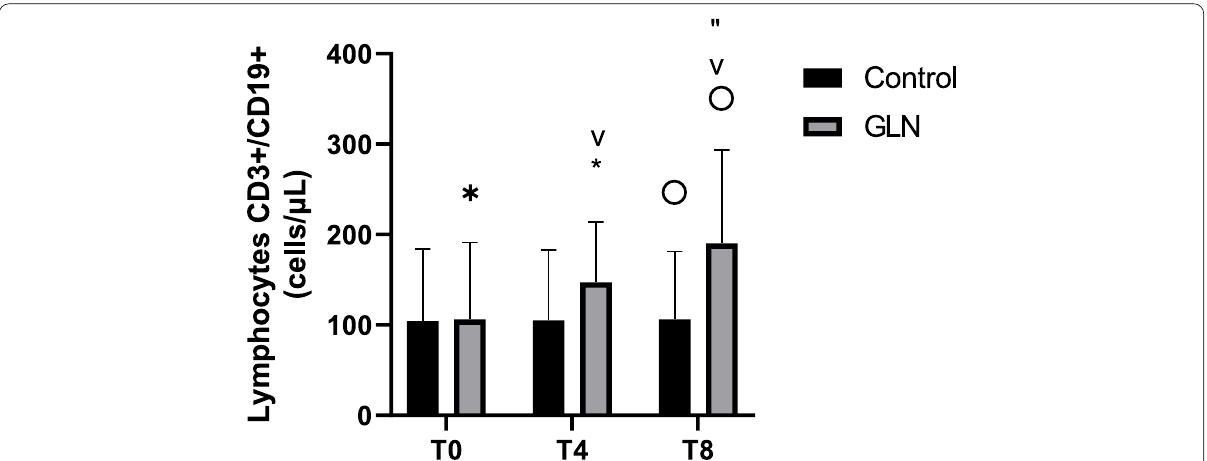
Fig. 4 B lymphocyte CD3 difference in GLN vs control at T8 ( p